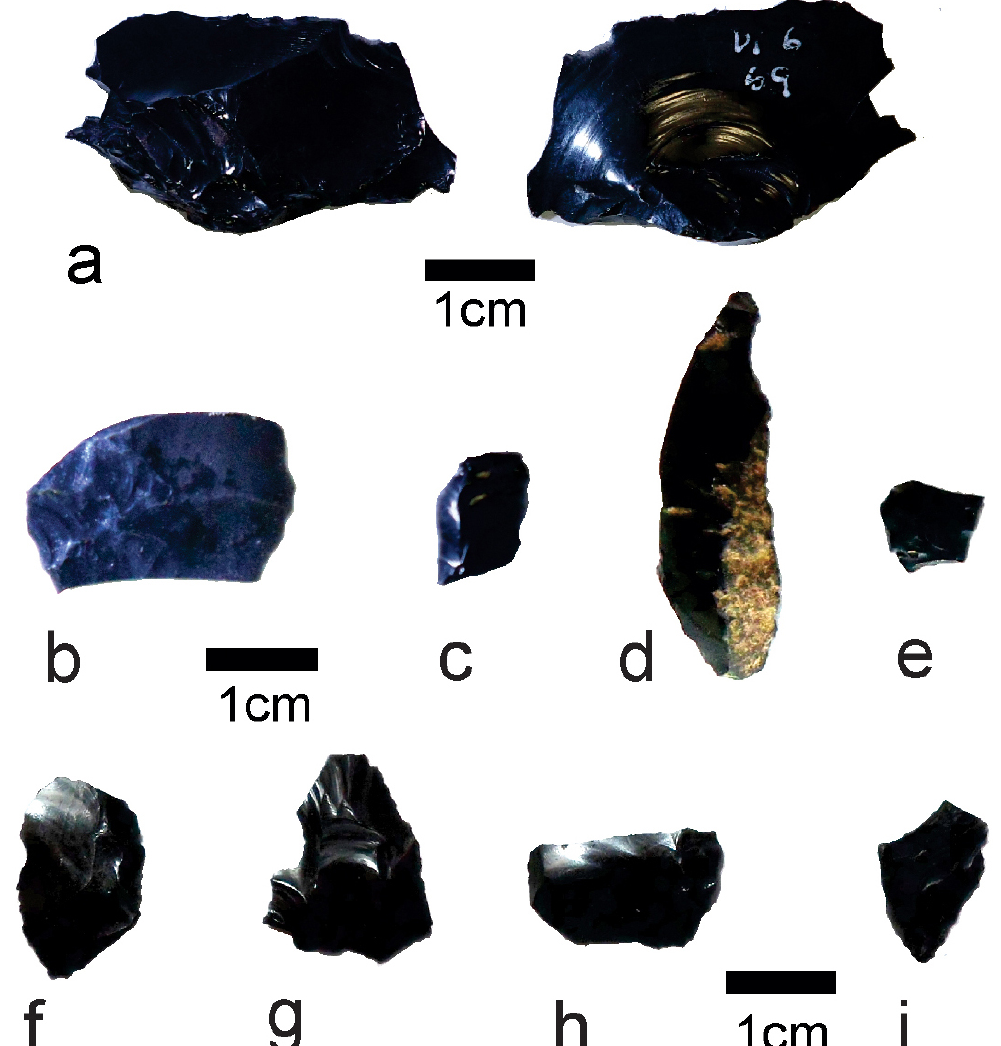
Figure 4. Sample of debitage. Early Holocene: a. core reduction flake, LV. Middle Holocene: b and d. Core reduction flakes from LV and LM respectively; c and e. Final shaping flakes from LV and LM respectively. Late Holocene: f, g, i. Final shaping debris (f. bifacial thinning flake), h. Core reduction